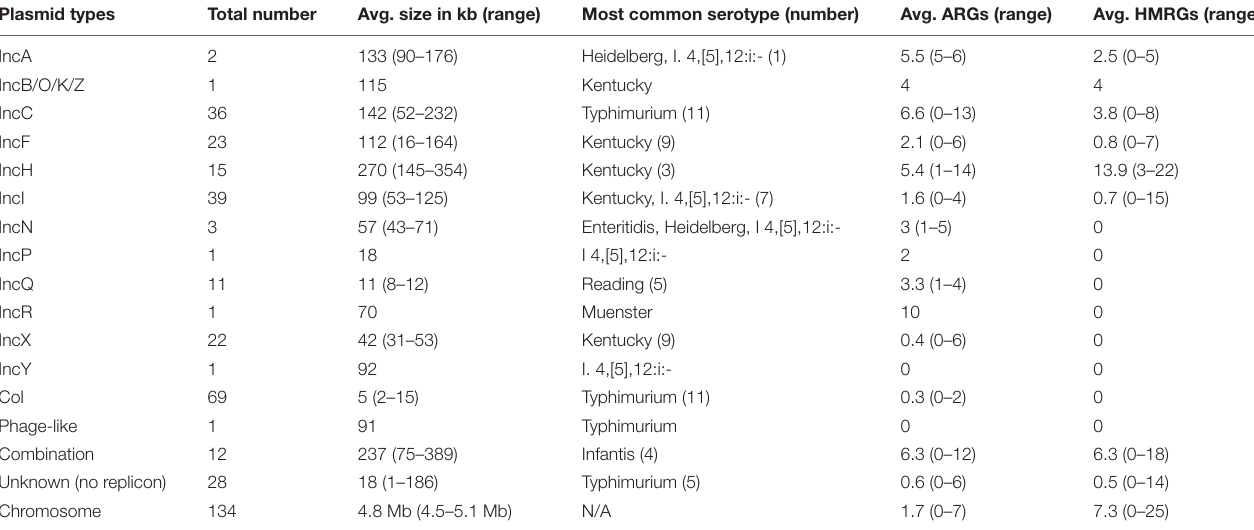
FIGURE 3 | Plasmid types present across different food animal sources. Replicon information was based on analysis from PlasmidFinder. Only the most common plasmid types are represented in the figure. TABLE 3 | Association of plasmid types with antimicrobial resistance genes (ARGs) and heavy metal resistant genes (HMRGs). Plasmid